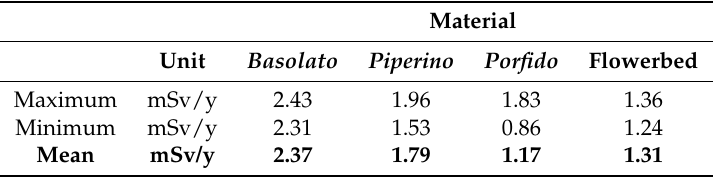
Table 1. Base statistics for effective dose values proceeding from flooring